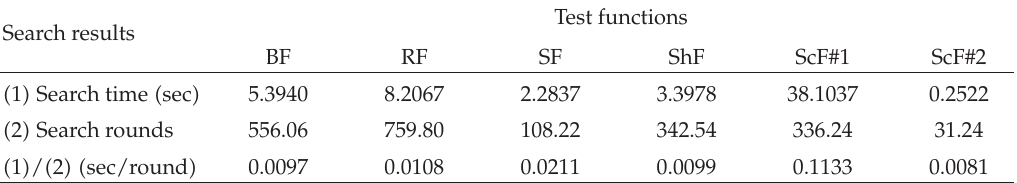
Table 3: Results of the ATS’s performance